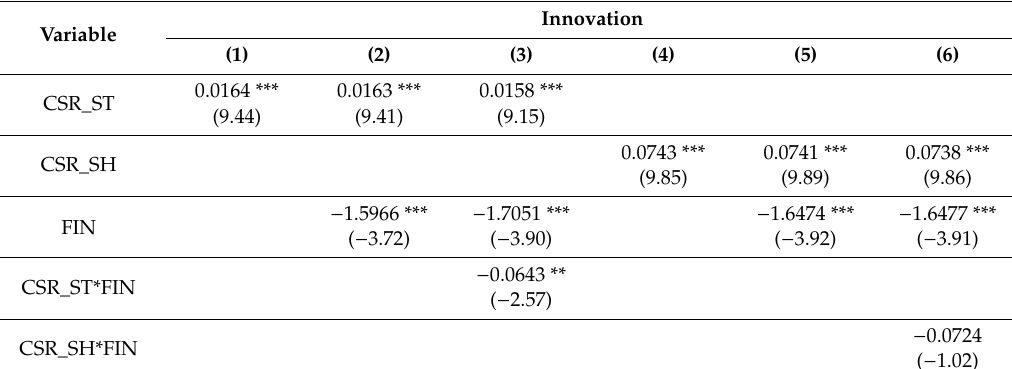
Table 8. Di ff erent CSR engagements of overall